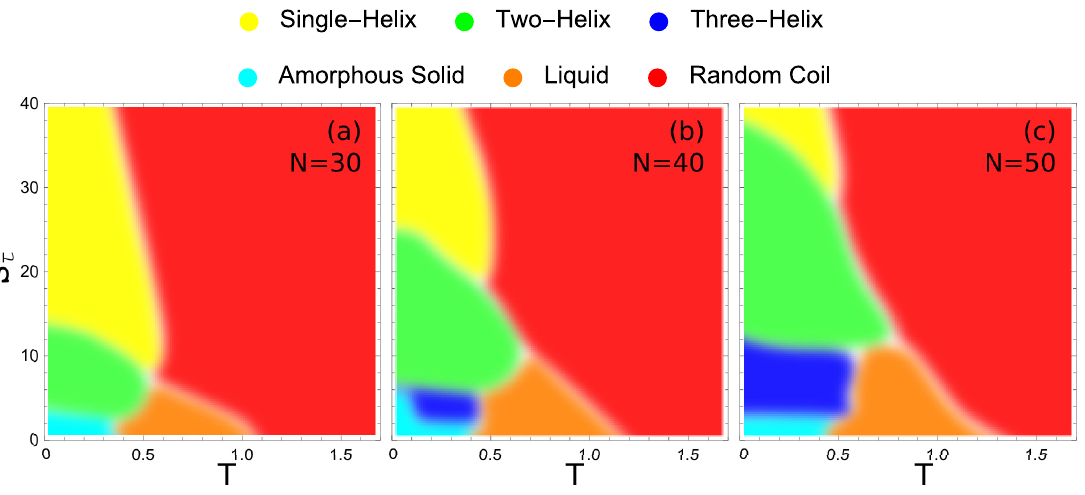
Figure 7. Hyper-phase diagrams for the ( a ) 30 mer, ( b ) 40 mer, and ( c ) 50 mer showing the regions of T − S τ space over which each particular structure type is dominant. The color key is found